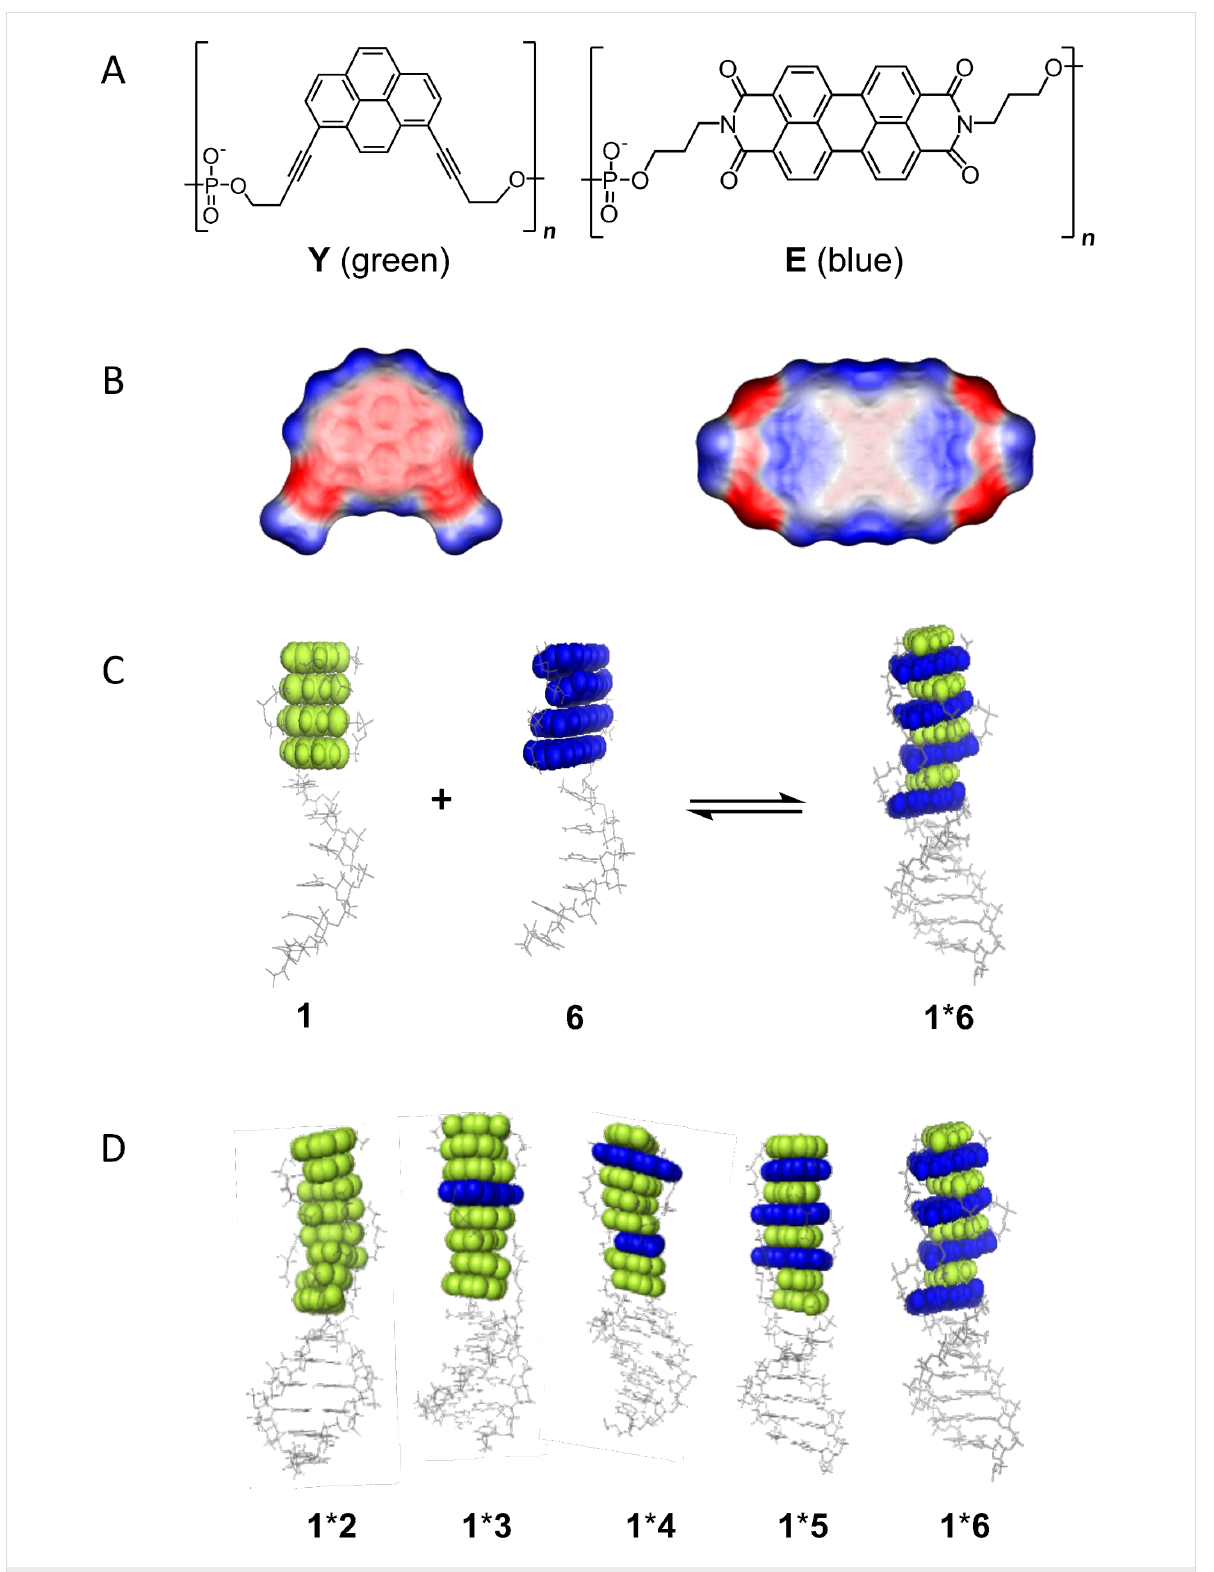
Figure 1: (A) Structures of 1,8-dialkynylpyrene ( Y ) and PDI ( E ); (B) illustration of the electrostatic potential surface of 1,8-diprop-1-ynylpyrene (left) and N , N ’-dimethyl-PDI (right); (C) illustration of duplex formation with chimeric oligomers; (D) hybrids 1 * 2 to 1 * 6 . The number of pyrene–PDI interac- tions increases from left to